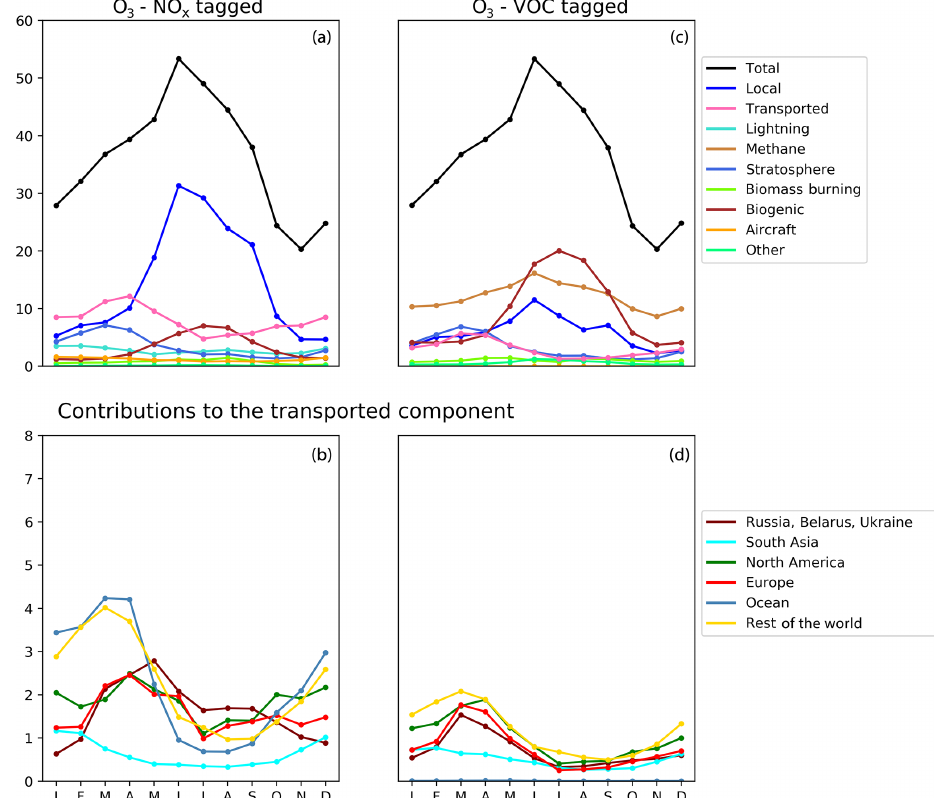
Figure 6. Seasonal cycle of surface ozone (ppb) in the HTAP Tier 2 receptor region “North East China”. NO x tagging is shown in panels (a) and (b) , and reactive carbon tagging is shown in panels (c) and (d) . Panels (a) and (c) show the total monthly mean ozone (black line) as well as the local anthropogenic component, the long-range transported anthropogenic component, the and natural components. Panels (b) and (d) show the individual Tier 1 source regions responsible for the long-range transported component of